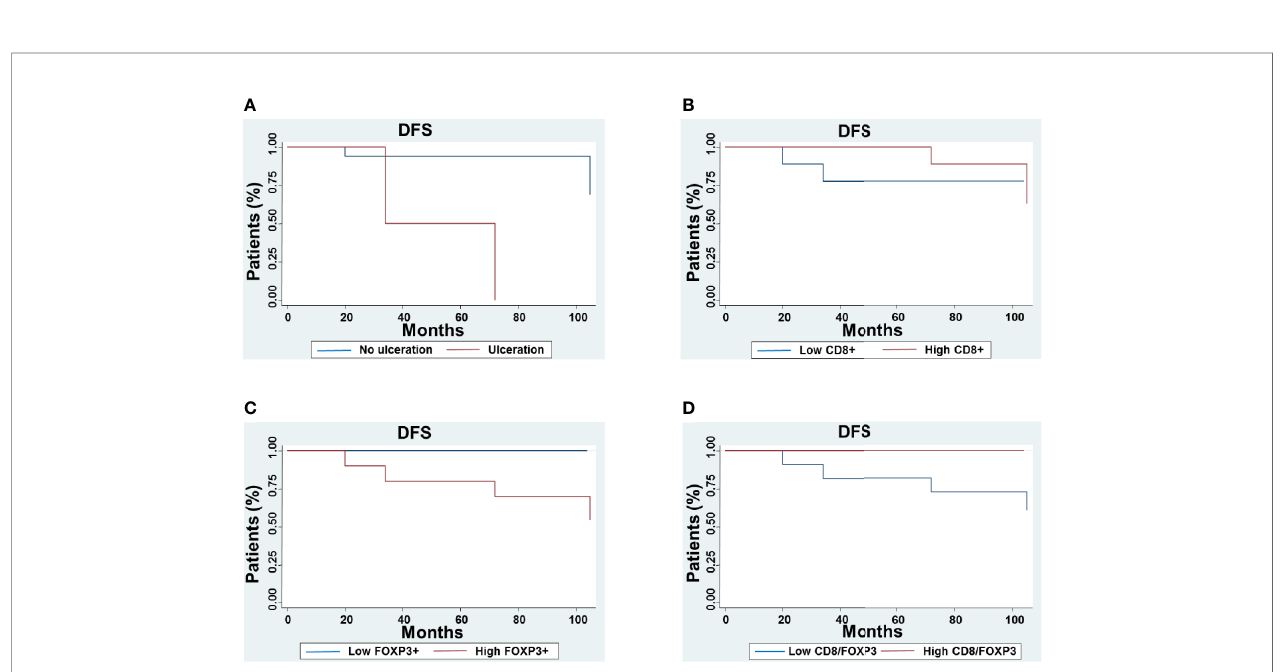
FIGURE 5 | Correlation between disease-free survival (DFS) and TIME characteristics in thin melanoma. The DFS of patients with lesions grouped based on ulceration (A) , number of peritumoral CD8+ T cells (B) , FOXP3+ cells (C) and CD8+/FOXP3+ T cell ratio (D) was compared using the Kaplan – Meier method.